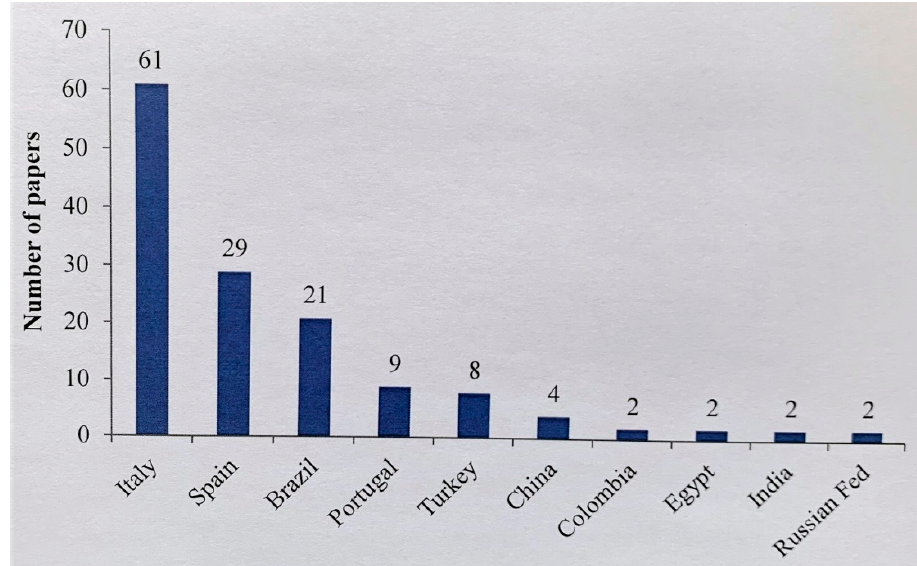
Figure 2. Geographical origin of scientific papers on waste recycling in porcelain stoneware mixes, since 2000.